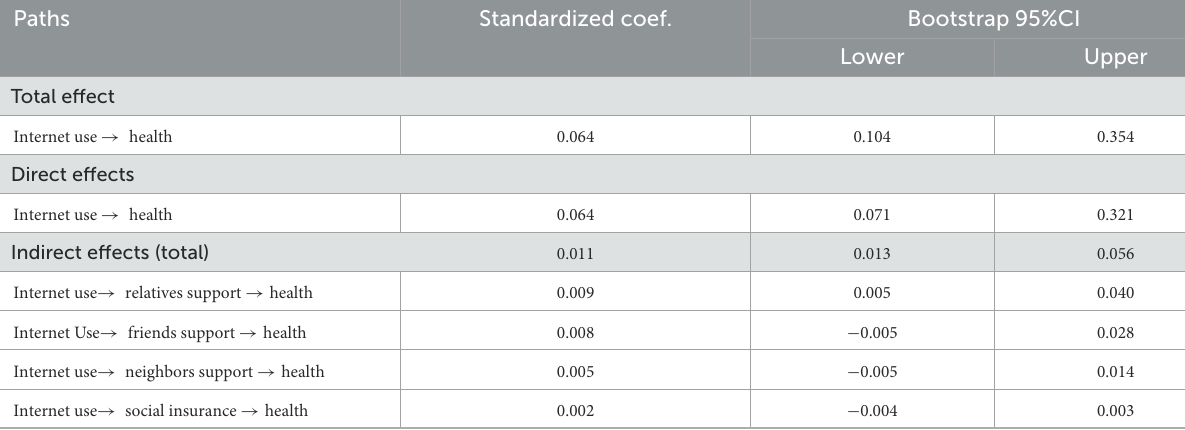
TABLE 7 Mediating effects of social support in rural areas.